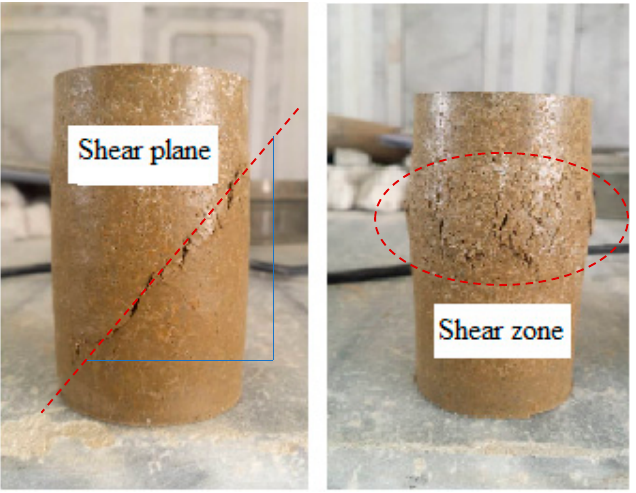
Figure 10. Failure mode of two soil samples differing only in reinforcement: unreinforced clay ( left ), clay reinforced with PP fibers ( right ).